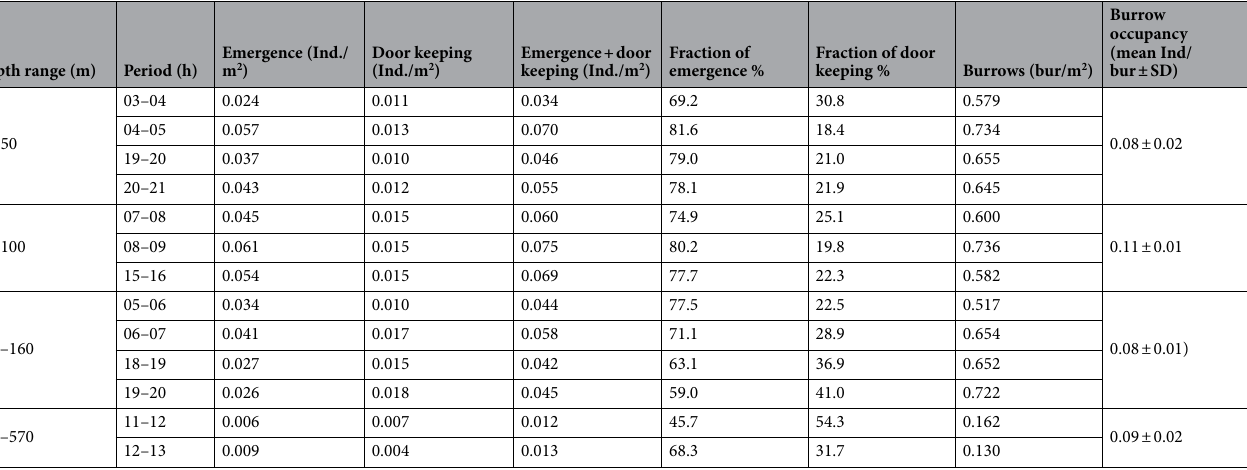
Table 3. Mean density (Ind./m 2 ) of N. norvegicus and burrow occupancy at periods with the predicted highest (maximum) number of animals displaying full emergence and door-keeping behaviour, as identified in Fig.